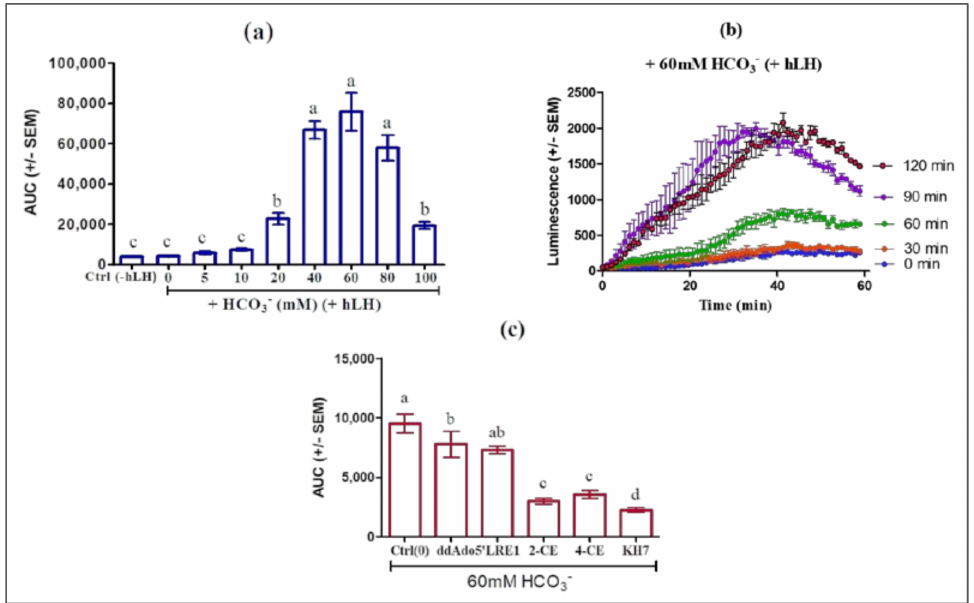
Figure 7. Inhibition of LH/HCO 3 − stimulation of MLTC-1 cells by soluble adenylyl cyclases (ADCY10) inhibitors KH7, 2-CE, 4-CE and LRE1. ( a ) Dose-dependent effect of HCO 3 − on the LH-stimulated intracellular cAMP accumulation in MLTC-1. The cells were preincubated for 60 min in HEPES buffer solution in the presence of different HCO 3 − concentrations before stimulation by 0.7 nM hLH and Control (Ctrl) (absence of HCO 3 − and hLH). ( b ) Kinetics of LH-stimulated intracellular cAMP accumulation after a 0 to 120 min preincubation in HEPES buffer solution in the presence of 60 mM HCO 3 − . ( c ) Effects of different ADCY10 inhibitors on the LH-stimulated intracellular cAMP accumulation in MLTC-1. The cells were preincubated in HEPES buffer solution with 60 mM HCO 3 − for 90 min and then exposed to KH7 (50 µ M), 2-CE (100 µ M), 4-CE (100 µ M) or LRE1 (100 µ M) or ddAdo5’ (250 µ M) for 30 min, before stimulation by 0.7 nM hLH. The values in all experiments are means ± SEM for n = 3 independent experiments. p value of <0.05 was considered statistically significant using a one-way ANOVA followed by the Dunnett’s test post-test. Different letters indicate significant differences between control (0 µ M) and each treatment at p <